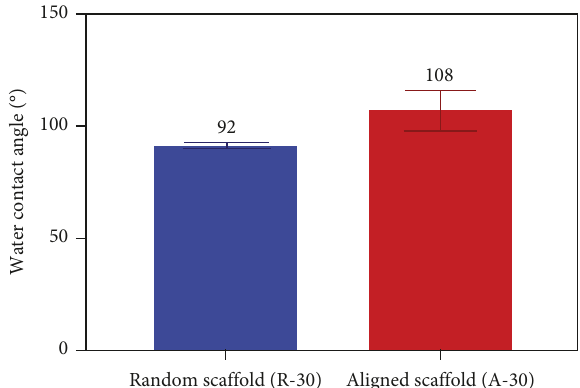
Figure 5: Te water contact angle of the fbrous